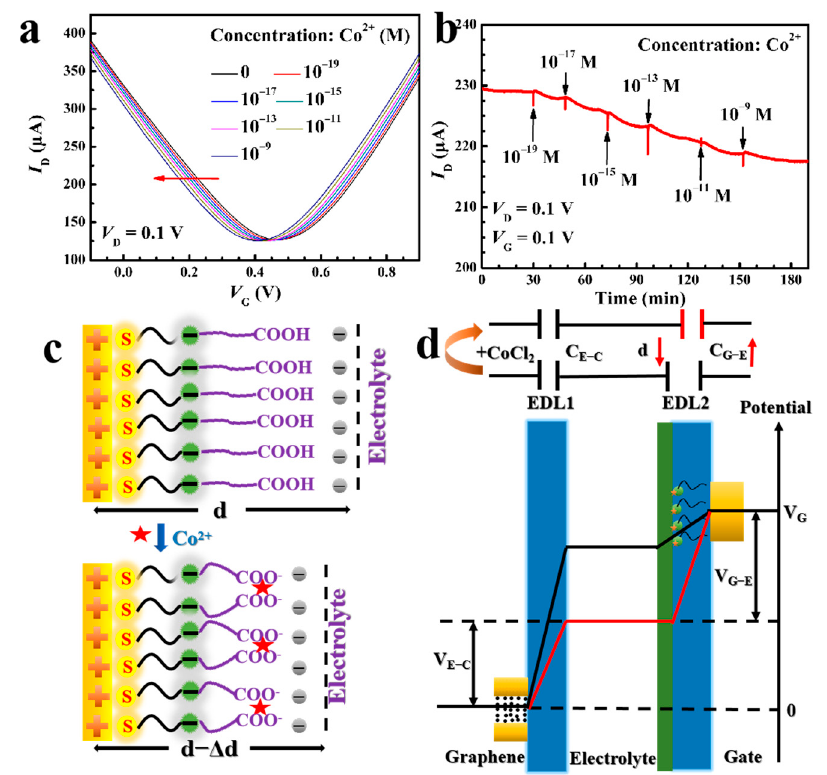
Figure 6 . ( a ) The transfer curves of the sensor at the different concentration of Co 2+ ions (replacing MAA with cysteamine); ( b ) channel current-time responses of the sensor at the different concentration of Co 2+ ions; ( c ) schematic diagram of EDL near gate electrode before and after the addition of Co 2+ ions; ( d ) potential drops across the two EDLs before and after the addition of Co 2+ ions.